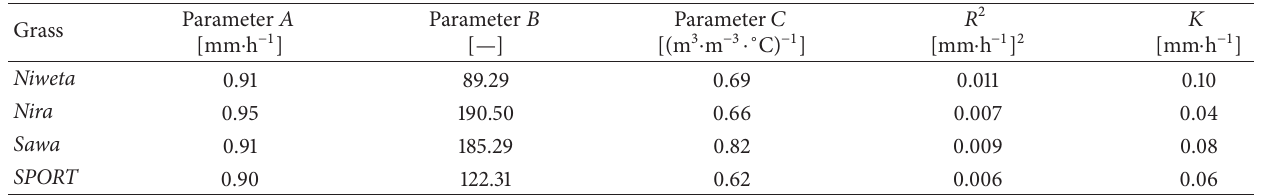
Table 1: Parameters 𝐴 , 𝐵 , and 𝐶 and measures of fit 𝑅 2 and 𝐾 . 𝑅 2 is calculated from relation (6) and 𝐾 is calculated from relation (7). Grass